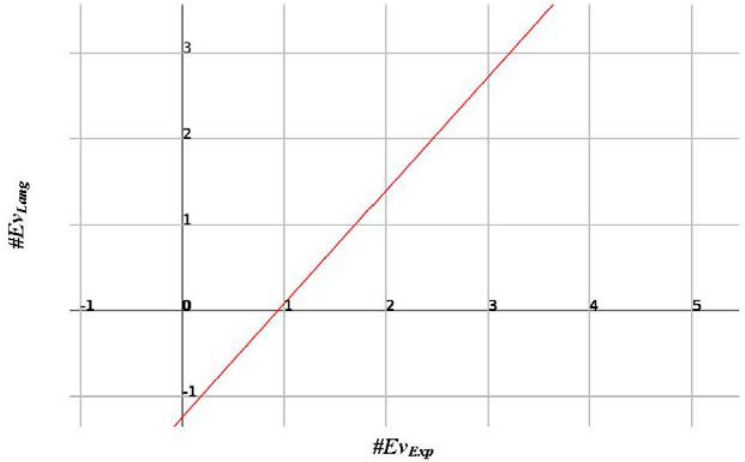
and Ev . Exp Lang